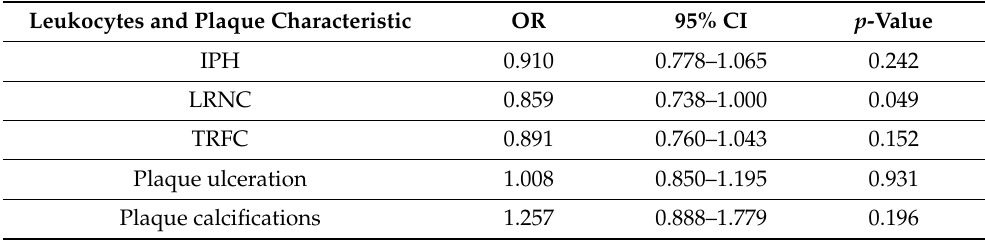
Table 3. Univariate logistic regression analyses for leukocyte count and individual vulnerable plaque